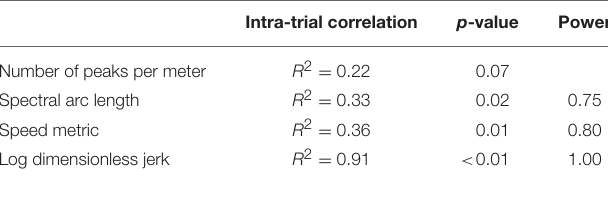
TABLE 3 | The R 2 -values of the intra-trial correlation, its p -values and power estimates for the four smoothness parameters.